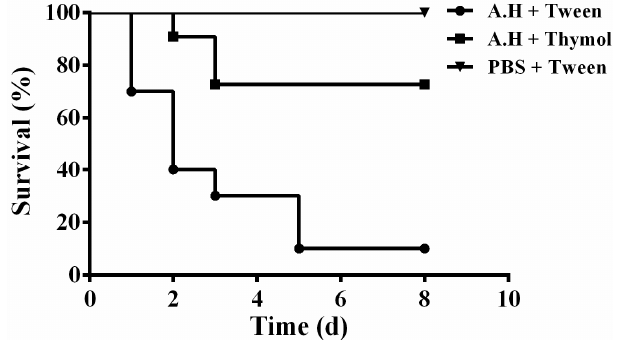
Figure 7. Thymol treatment increased the survival of channel catfish post infection. Infected channel catfish were administered with thymol or PBS, and the survival of the channel catfish was monitored for 8 days. A.H + Tween: group infected with A. hydrophila and treated with 10% Tween 80; A.H + Thymol: group infected with A. hydrophila and treated with thymol; PBS + Tween: group infected with PBS and treated with 10% Tween 80. The survival rate for the thymol ‐ treated group was significantly increased compared to the positive control group when analyzed by the log ‐ rank test ( p < 0.0001 for the thymol ‐ treated